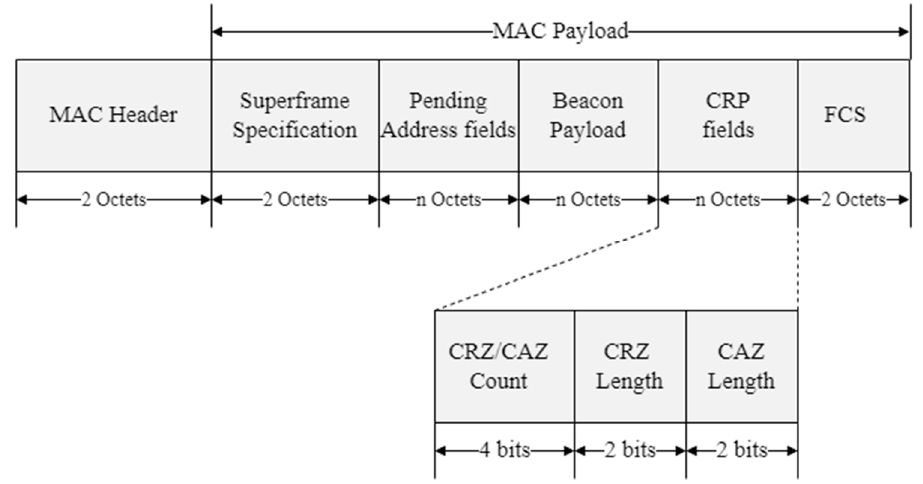
Figure 5. The format of the proposed beacon frame.